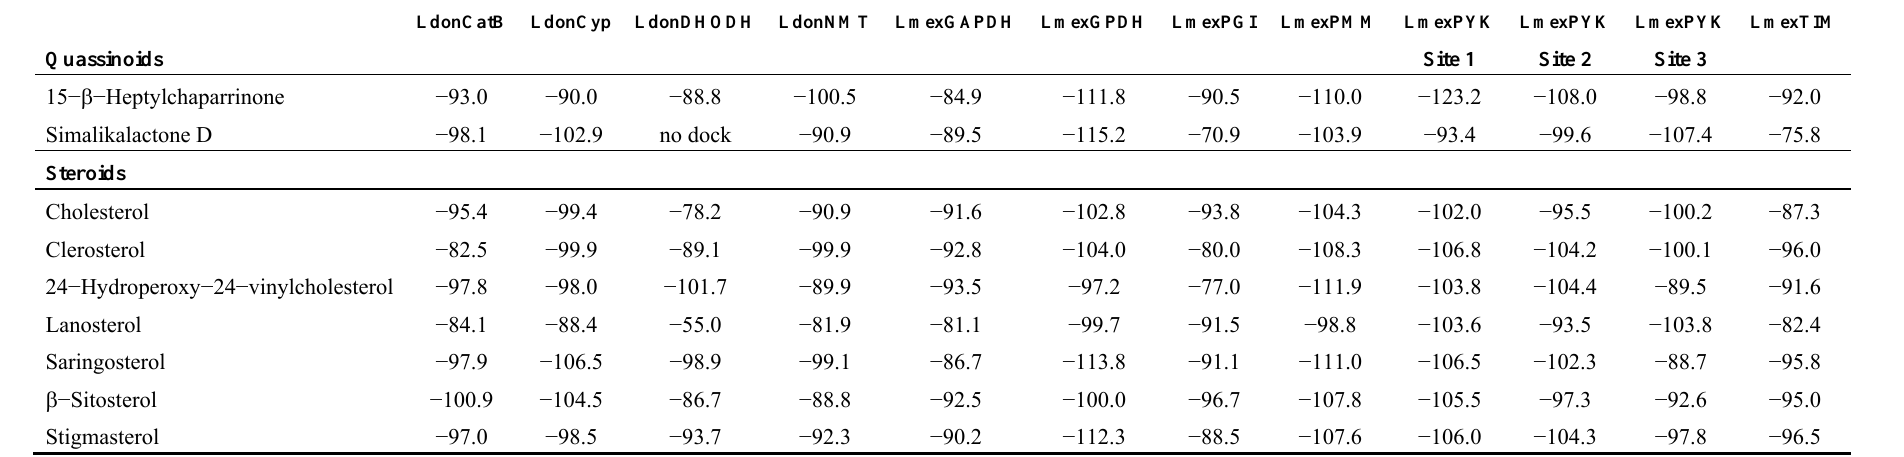
Table 39. MolDock docking energies (kJ/mol) of quassinoids and steroids with Leishmania donovani and L. mexicana protein